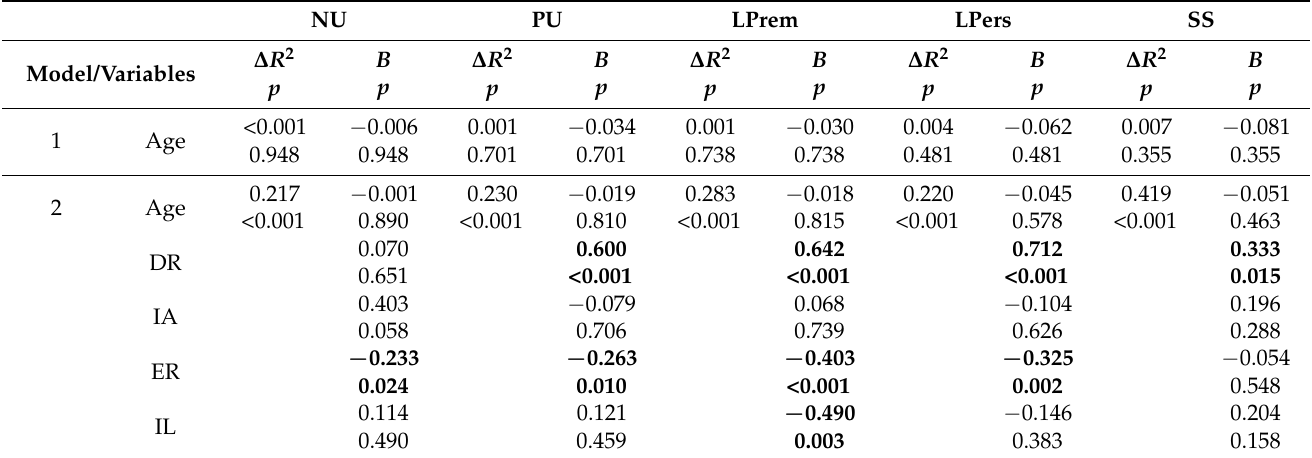
Table 4. Regression models for